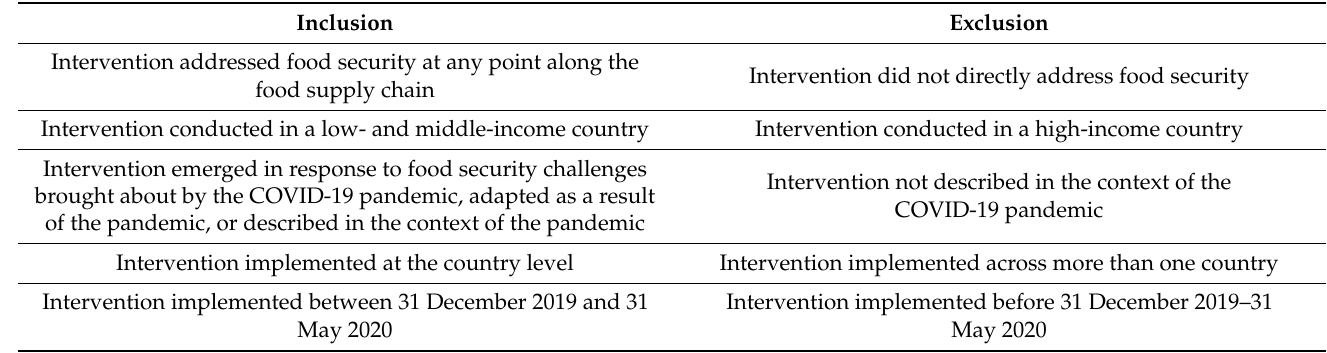
Table 2. Inclusion and exclusion criteria used to identify interventions addressing food insecurity in the context of COVID-19 in low- and middle-income countries from 31 December 2019 to 31 May